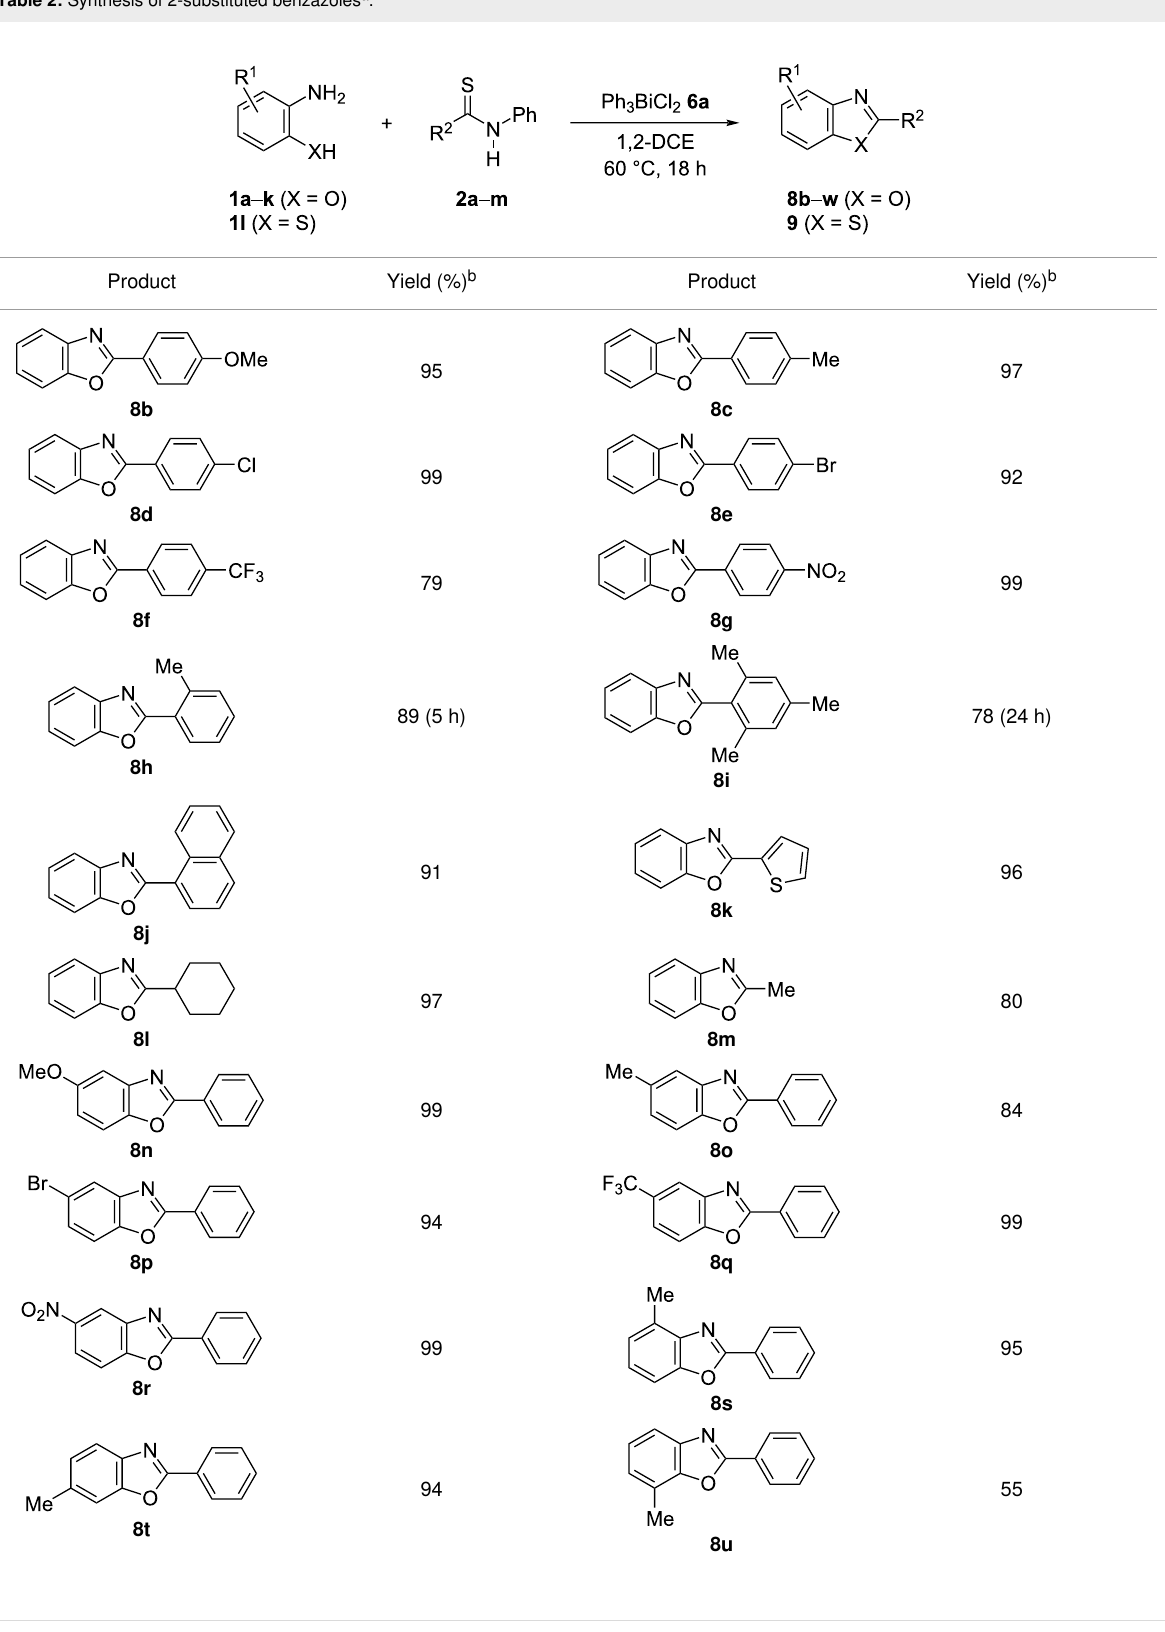
Table 2: Synthesis of 2-substituted benzazoles a